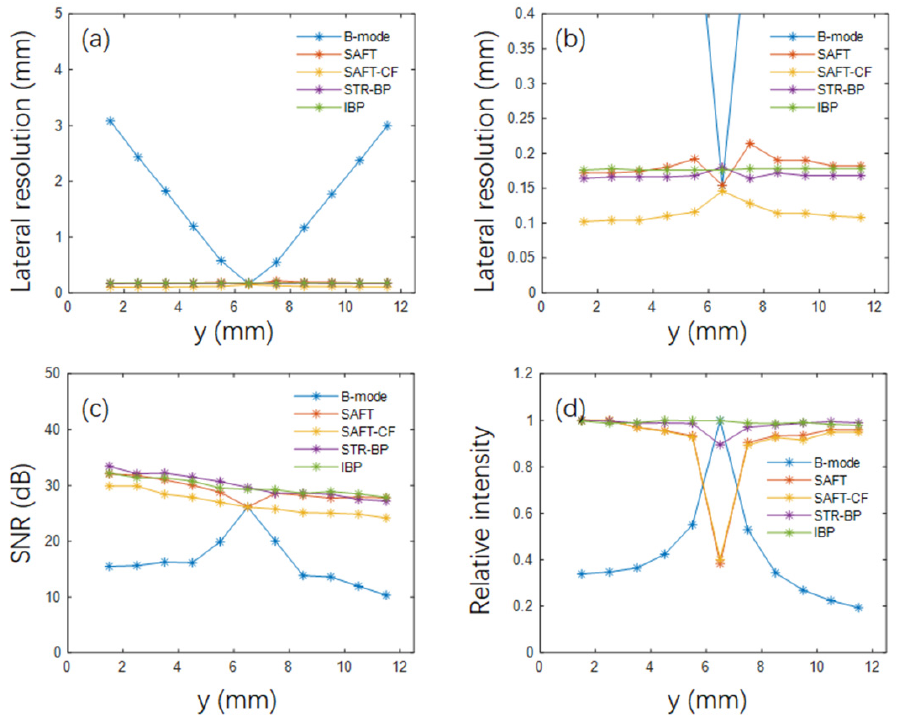
Figure 4. The comparison of lateral resolution ( a , b ), SNR ( c ), and relative intensity ( d ) given by different reconstruction methods for targets at different depths.